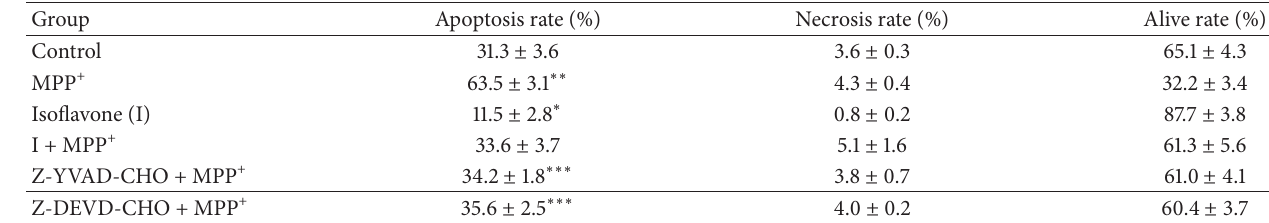
Figure 1 Table 2: Apoptosis rate (%) of PC12